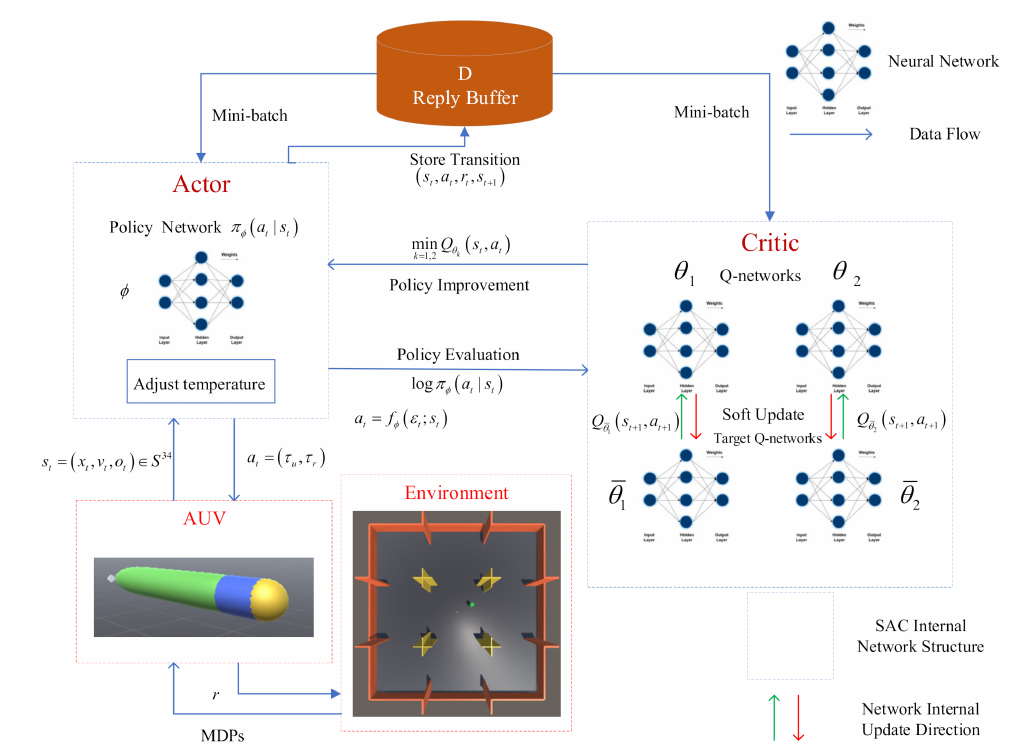
Figure 4. Neural network structure of the SAC algorithm. The algorithm flow of this article based on SAC shown in Algorithm